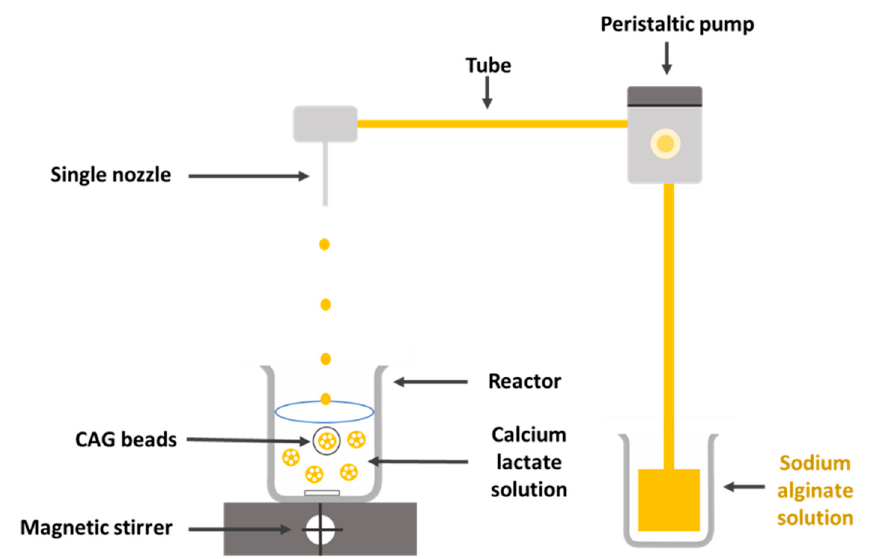
Figure 1. Simple schematic diagram for the preparation of calcium alginate gel (CAG) beads using a single nozzle.